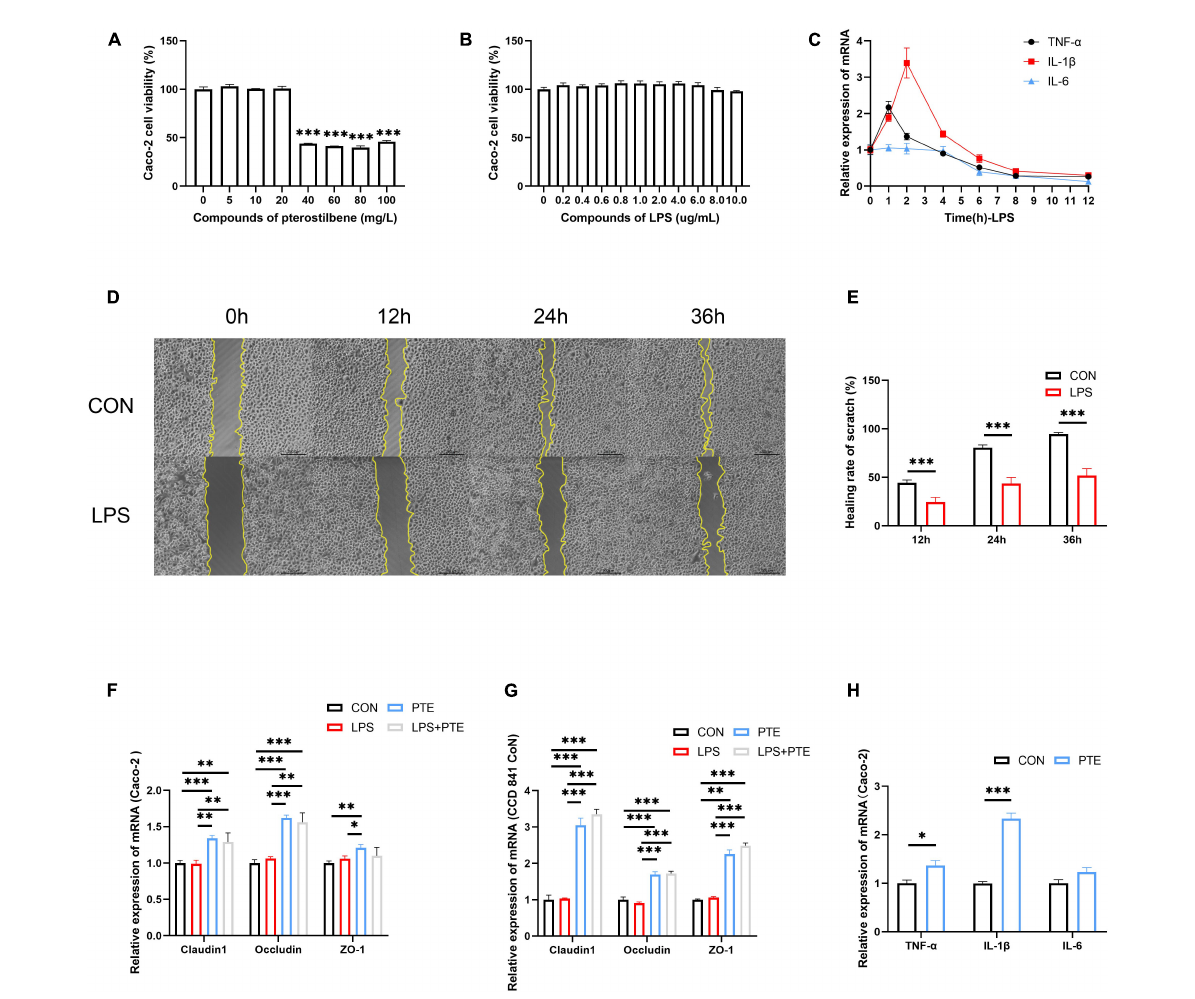
FIGURE5 PTE preserve TJ integrity in vitro . (A,B) The cell viability of Caco-2 cells after pterostilbene (0, 5, 10, 20, 40, 60, 80, and 100 mg/L) or LPS (0, 0.2, 0.4, 0.6, 0.8, 1.0, 2.0, 4.0, 6.0, 8.0, and 10.0 µ g/ml) intervention. (C) The mRNA expression of inflammatory gene (TNF- α , IL-1 β , and IL-6) induced by LPS (1 mg/ml) at 1, 2, 4, 6, 8, and 12 h. (D,E) The healing rate of LPS-treated cells by the scratch test. (F) The expression of TJ-related gene after PTE (20 mg/L) treatment by qPCR analysis in Caco-2 cells (claudin1:LPS: F = 0.398, p = 0.540; PTE: F = 44.602, p < 0.001; interaction: F = 0.174, p = 0.684. occludin: χ 2 = 1.333, p = 0.248.ZO-1: LPS: F = 0.380, p = 0.549; PTE: F = 8.755, p < 0.05; interaction: F = 4.126, p = 0.065), (G) CCD 841 CoN cells (claudin1: LPS: F = 1.930, p = 0.190; PTE: F = 327.213, p < 0.001; interaction: F = 1.196, p = 0.296. occludin: LPS: F = 0.283, p = 0.604; PTE: F = 166.214, p < 0.001; interaction: F = 1.125, p = 0.310.ZO-1: χ 2 = 2.083, p = 0.149). (H) the expression of inflammatory gene in Caco-2 cell between CON and PTE (20 mg/L). Data were expressed as means ± SEM, and the statistical significance was showed using asterisks denote ( ∗ p < 0.05; ∗∗ p < 0.01; ∗∗∗ p <